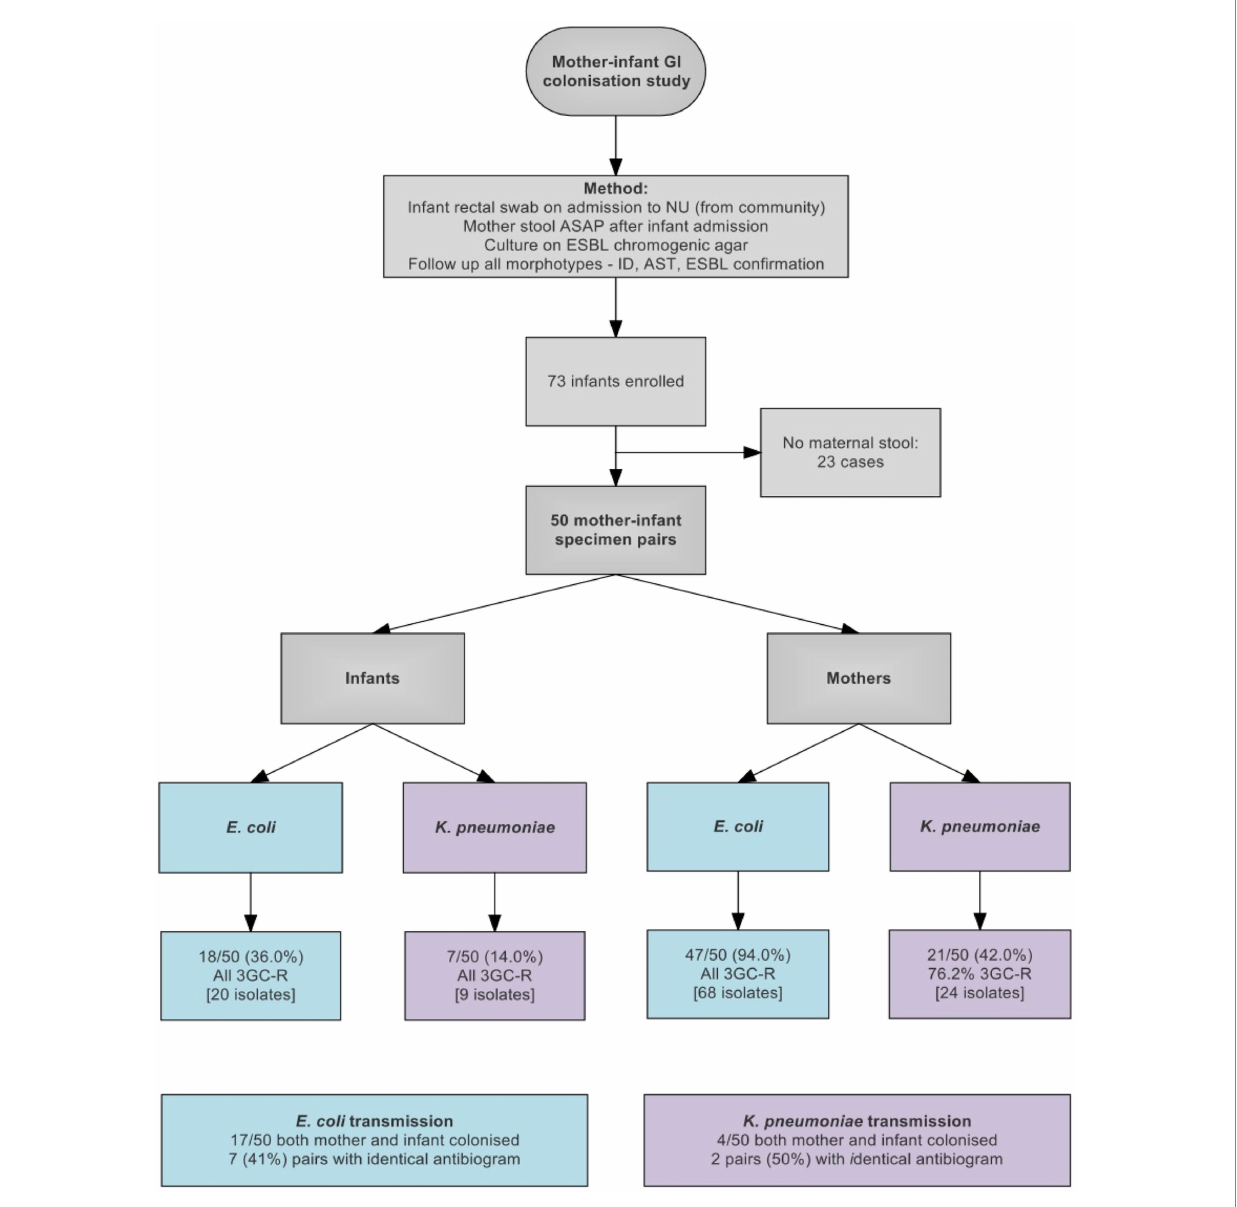
FIGURE 1 Flow diagram showing study design and sample collection. 3GC-R, third generation cephalosporin